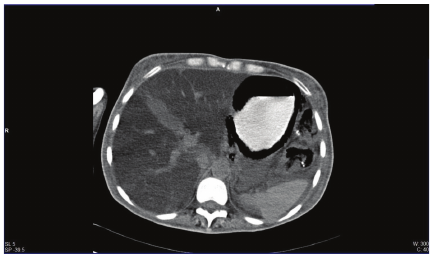
Figure 4: Computed axial tomography of the abdomen with oral contrast agent enhancing the